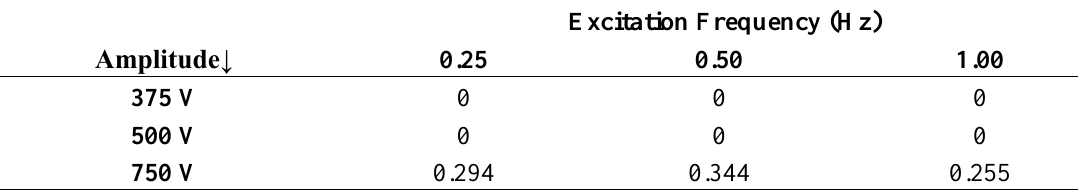
Table 13. Variation of the backlash threshold parameter a 2